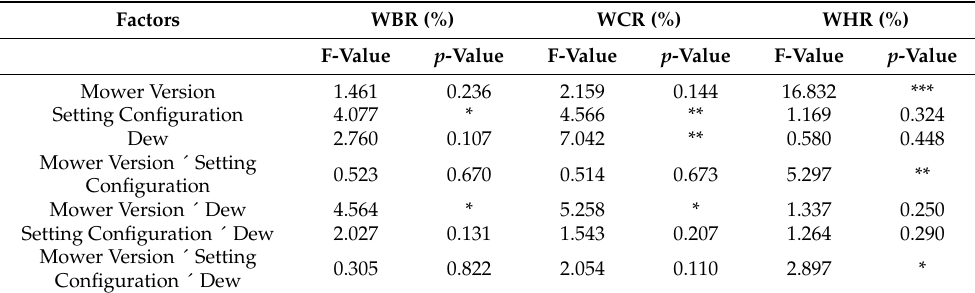
Table 5. F-value and p -value estimations from three-way ANOVA.